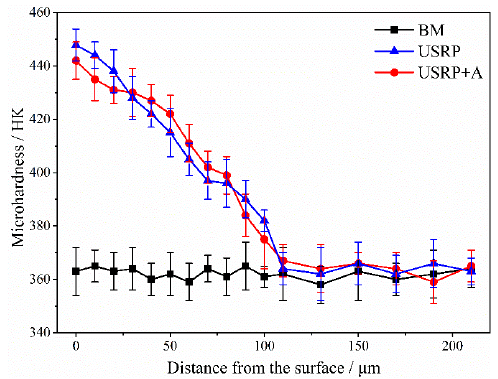
Figure 6. The results of micro-hardness distribution along the cross-section of samples with different treatments.